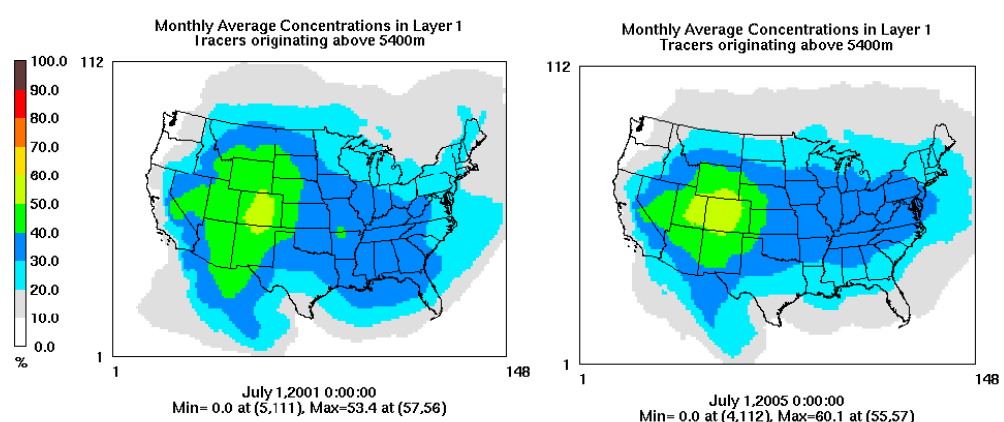
Fig. 9. Percent contribution of tracers originating above 5400m to the surface layer concentrations using 2001 and 2005 meteorological files. Contributions are based on monthly averages of tracer concentrations.